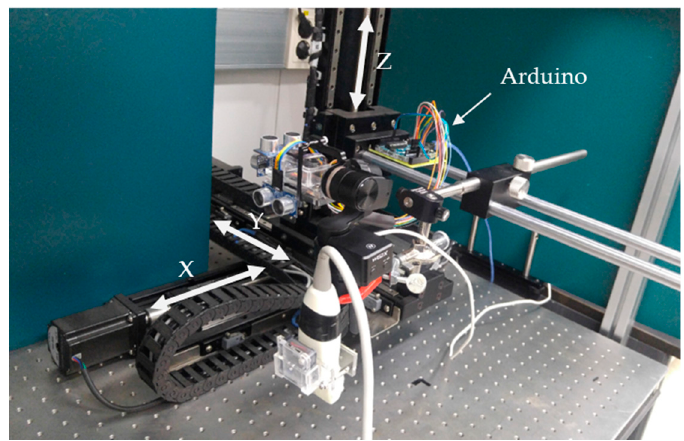
Figure 4. Experimental setup for the identification of the position data with the use of the XYZ stage, including the ultrasound probe with low-cost devices.